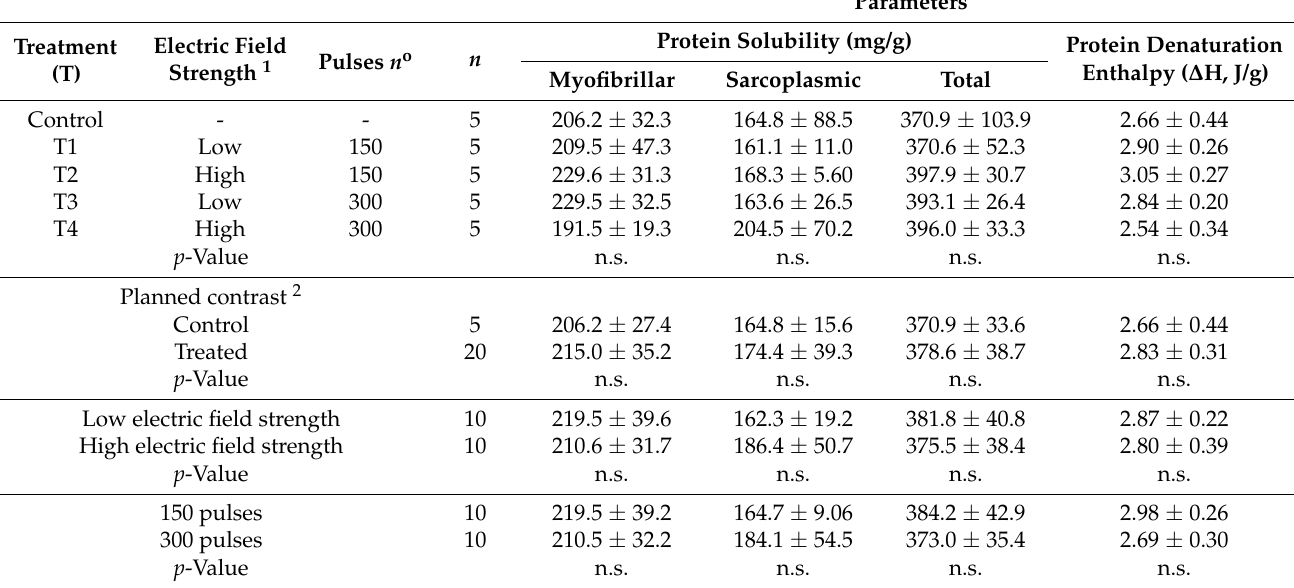
Table 4. Average protein solubility (mg/g) and total protein denaturation enthalpy ( ∆ H, J/g) of chicken meat samples subjected or not to pulsed electric field treatments. Data are expressed as least square means ± standard deviation. n.s. = not